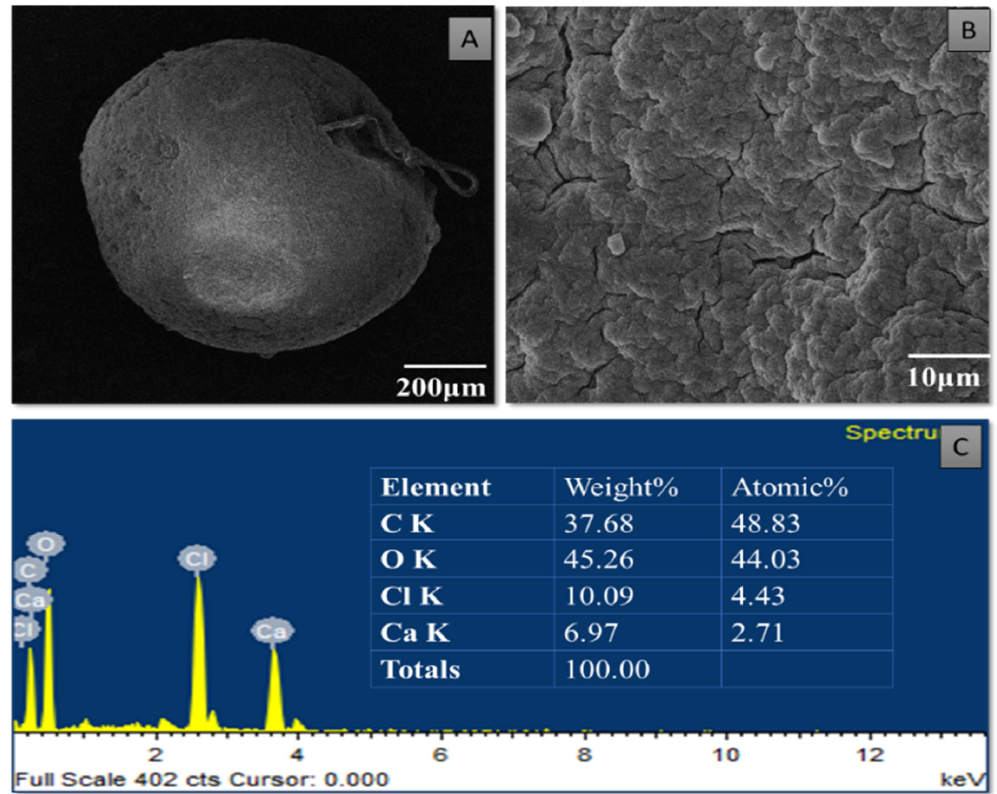
Figure 5. SEM/EDX of TiO 2 nanoparticles. ( A ) SEM image of TiO 2 nanoparticles at 500 nm. ( B ) EDX of TiO 2 nanoparticles.